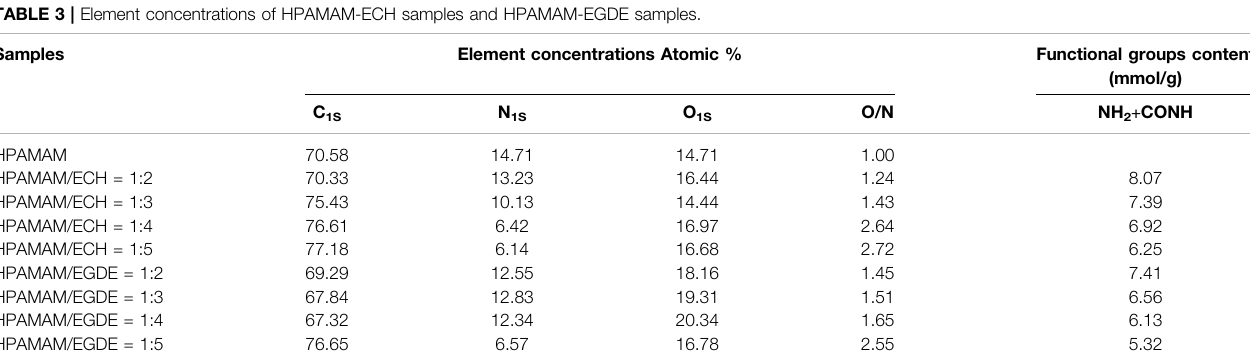
TABLE 3 | Element concentrations of HPAMAM-ECH samples and HPAMAM-EGDE samples.